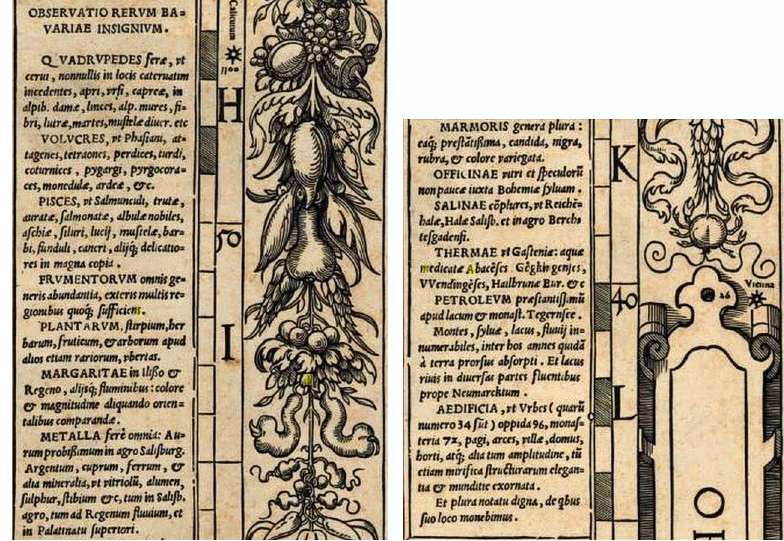
Fig. 3. “Remarks on peculiar things in Bavaria” on sheet no. 12 of the map by Ph. Apian,